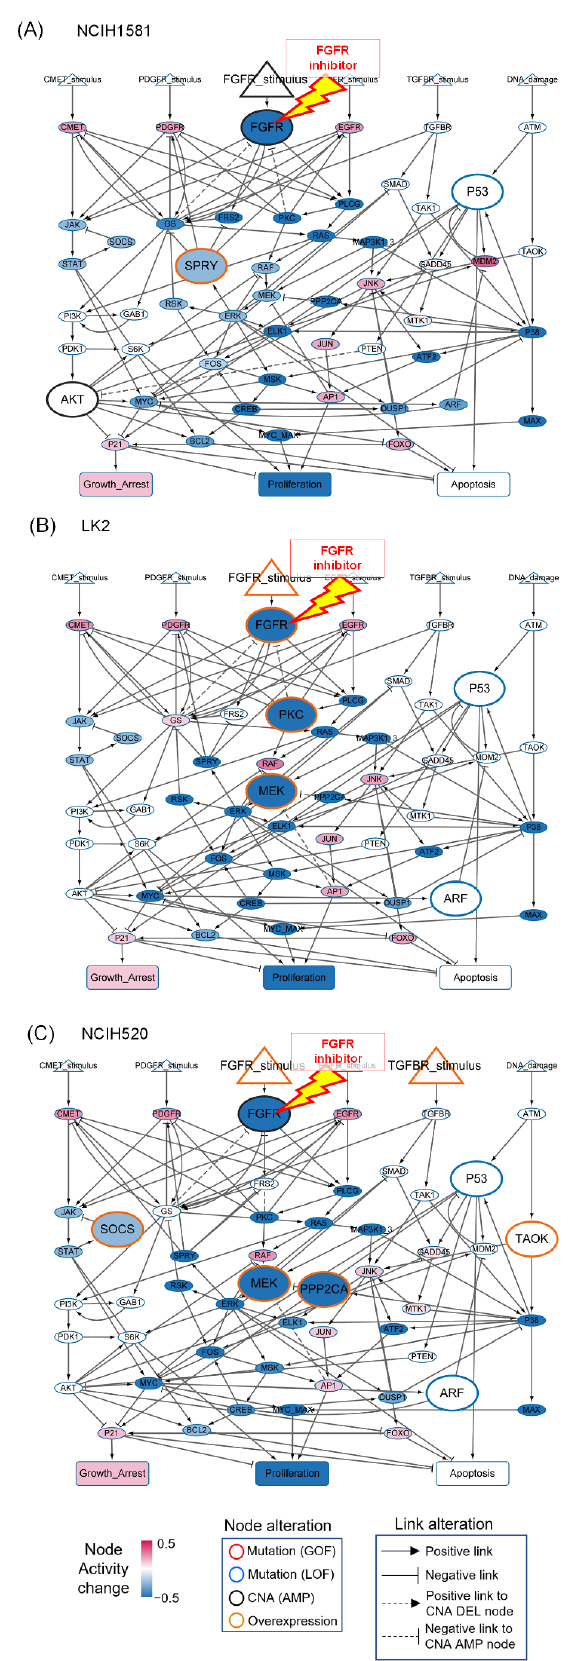
Figure 3. Responses to FGFR inhibitor from the sensitive cell line-specific network models.